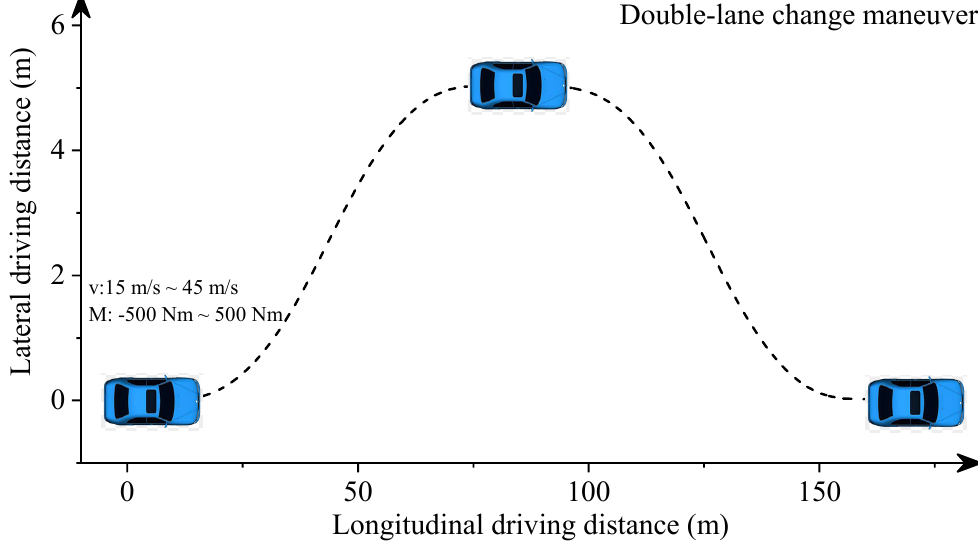
Figure 2. The driving track of the